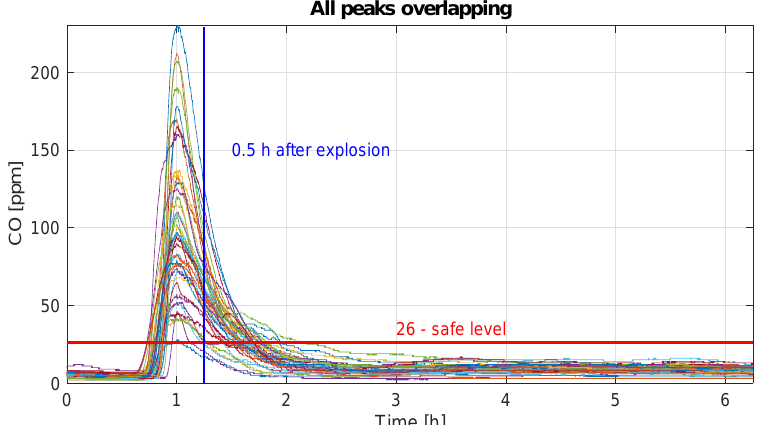
Figure 8. Recorded peaks overlapping according to the fixed time frame. The yellow vertical line indicates 30 min waiting time after blasting and the red horizontal line points the safe level of gas concentration.